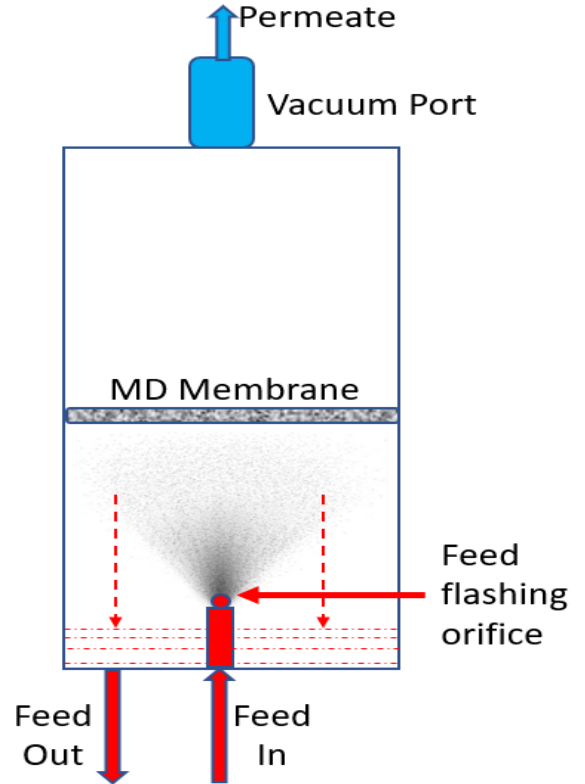
Figure 7. A schematic of the FF-VMD membrane